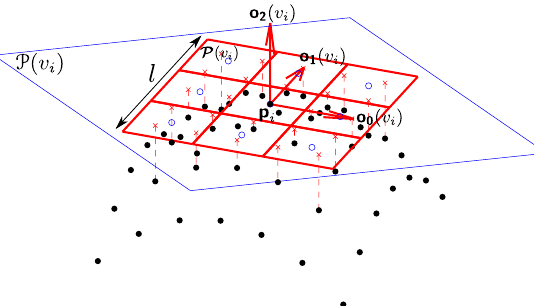
Figure 1. Interpolation of the content of the patch with a patch length of l > 0. (cid:126) o 0 ( u ) and (cid:126) o 1 ( u ) are the orientations of the patch (cid:126) P ( u ) at a point (cid:126) p u . Elements marked by a “ × ” symbol correspond to the projected neighbors (cid:126) p (cid:48) u of the point (cid:126) p u on the patch. These projections are used to deduce the values of each patch cell (a “o” symbol) by a weighted average of the associated graph signal